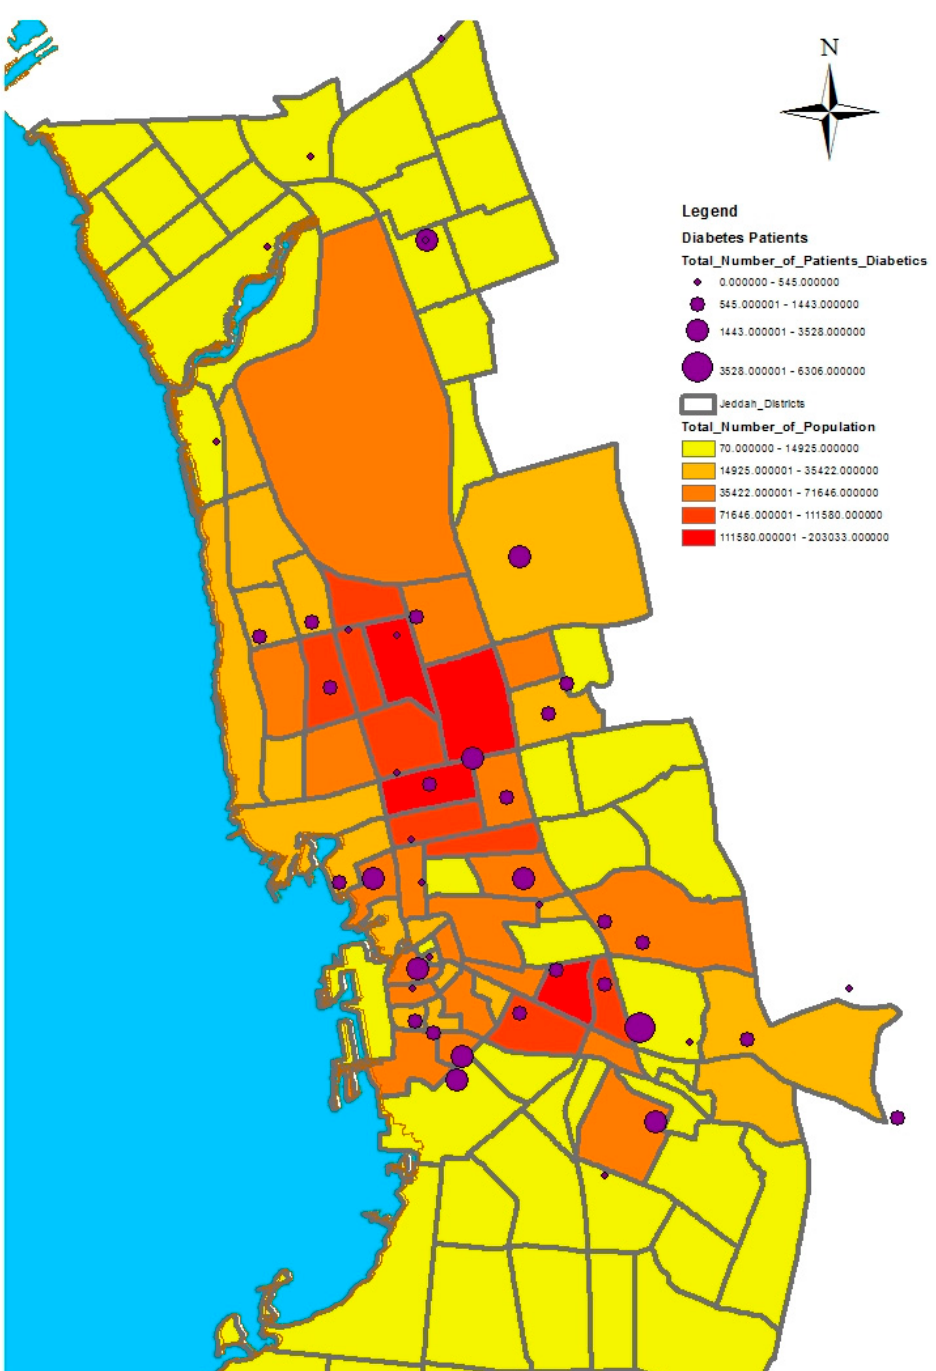
Figure 3. Spatial distribution of diabetes patients.